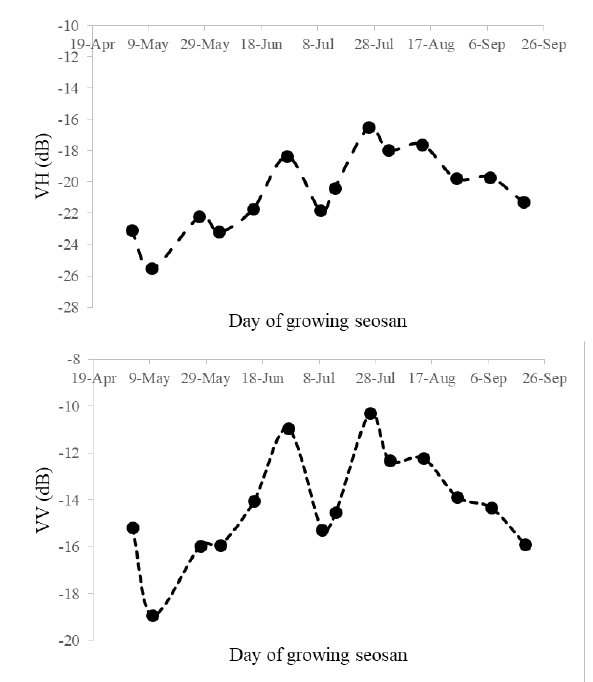
Figure 6. Times courses of (a) VH and (b) VV captured at the 133 polygons of current wheat cropping area from cadastre data in the studied field, for each date, between May and September 2019.